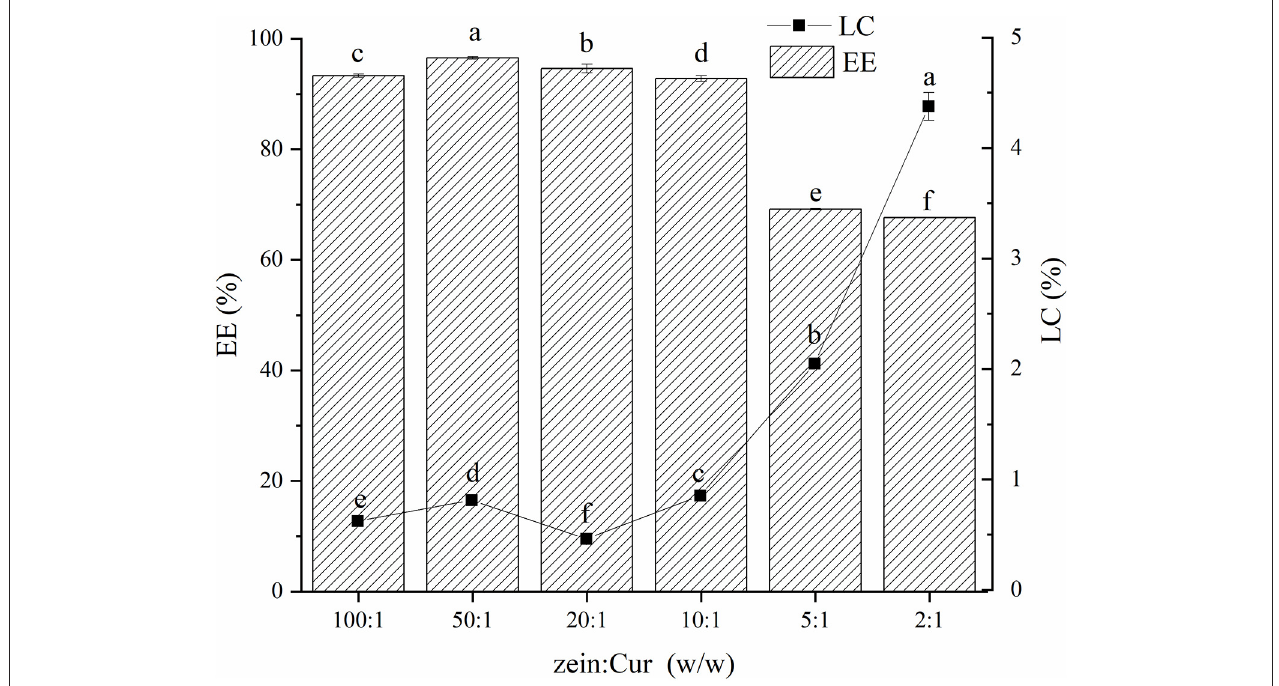
FIGURE 3 | Encapsulation efficiency and loading capacity of curcumin (Cur) in ZGT-Cur composite nanoparticles at different mass ratios of zein to curcumin.